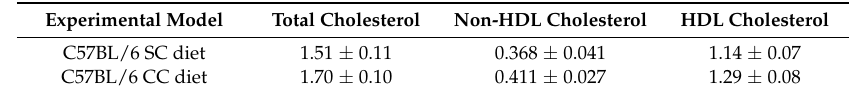
SC diet: standard chow diet. CC diet: standard chow diet supplemented with 0.2% cholesterol 10% coconut oil. HDL: high-density lipoproteins. Data are expressed as means ± SEM. ( n = 10).